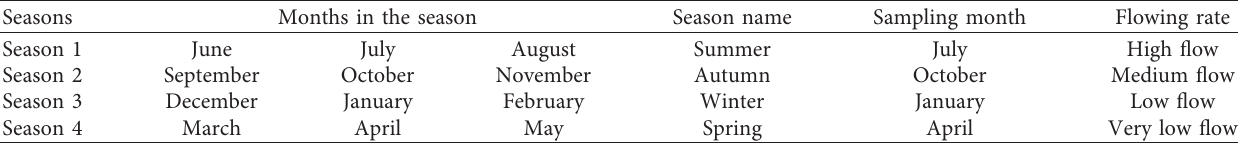
Table 2: Sampling seasons and seasonal flow